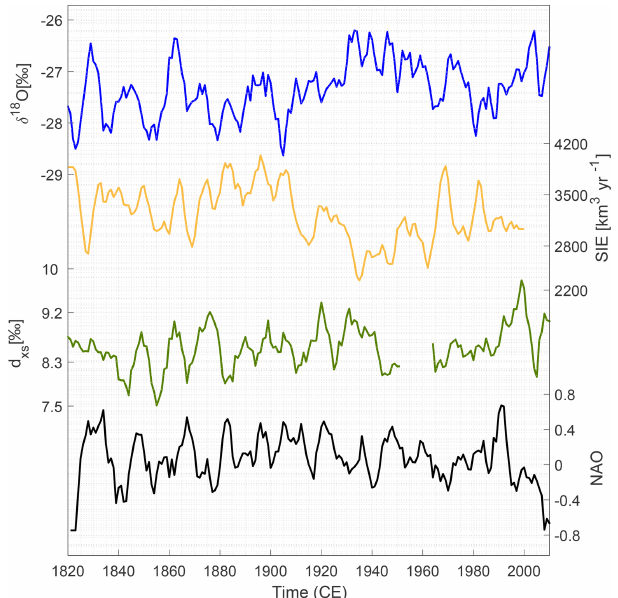
Figure 9. Annually averaged δ 18 O stack (blue curve), Fram Strait SIE (yellow curve), d xs (green curve) and NAO index (black curve). A 5-year moving average has been applied to all the data.